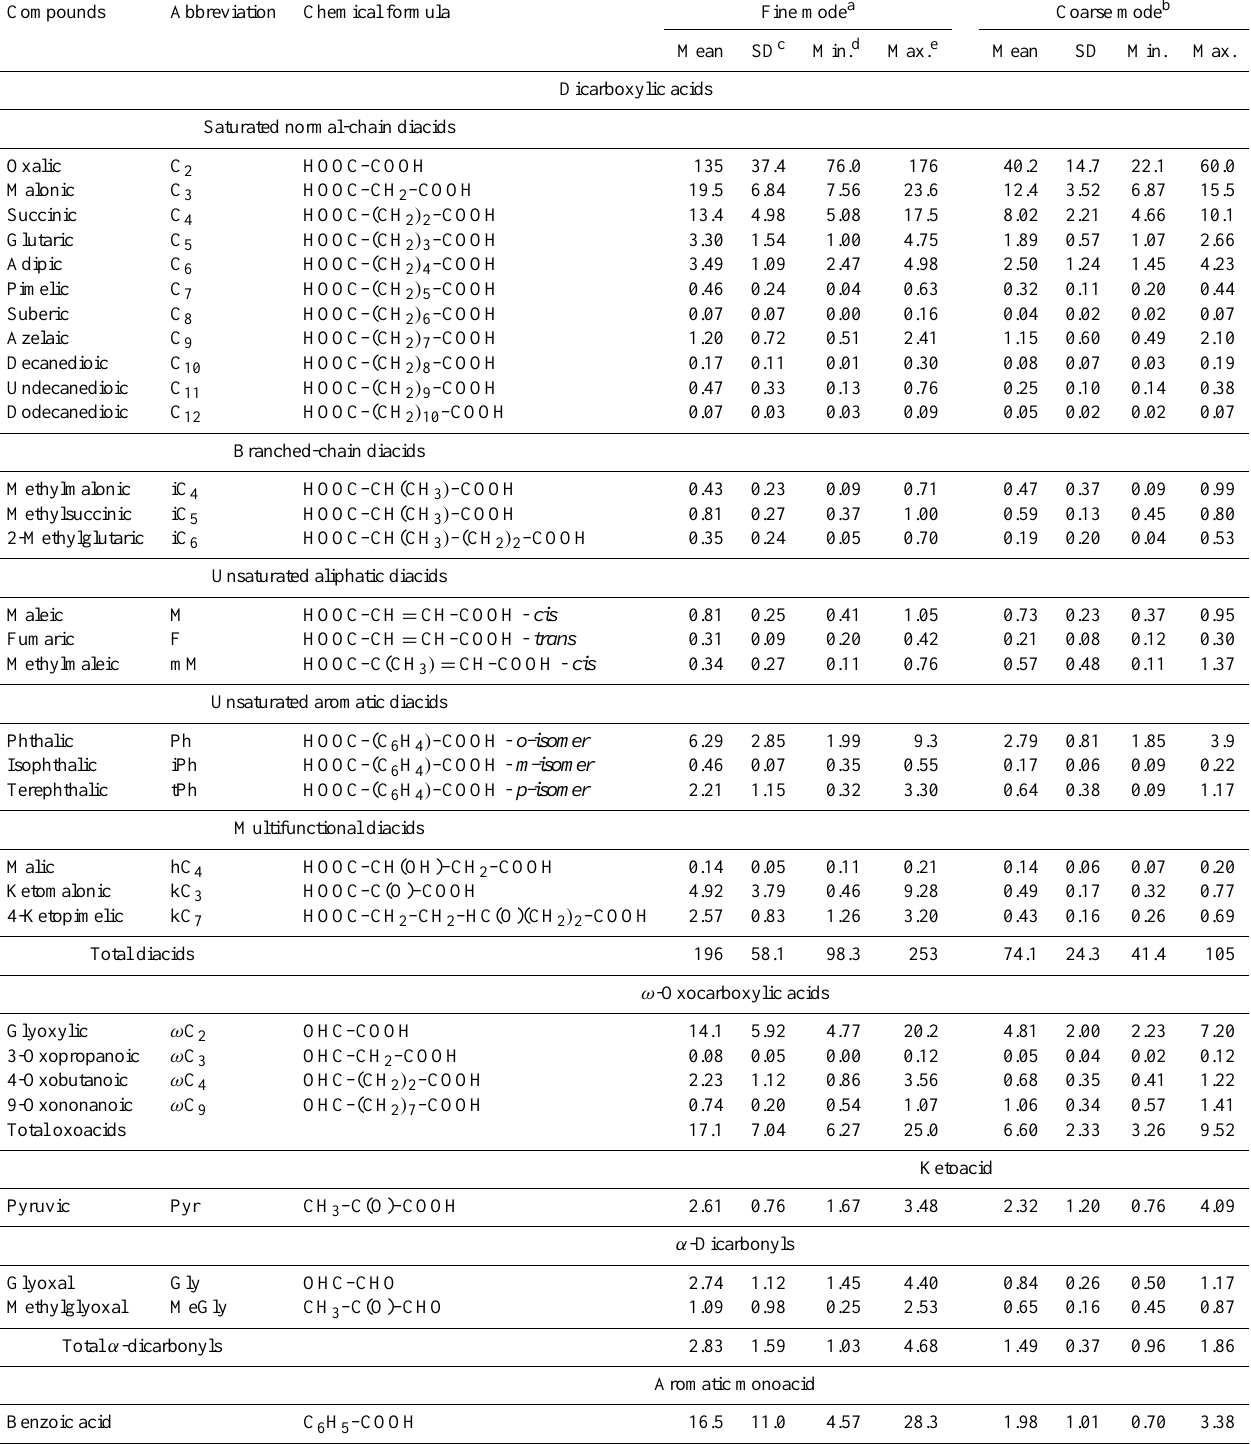
Table 2. Summarized concentrations (ngm − 3 ) of water-soluble dicarboxylic acids and related polar compounds in the fine- and coarse-mode aerosols from Okinawa Island in the western North Pacific